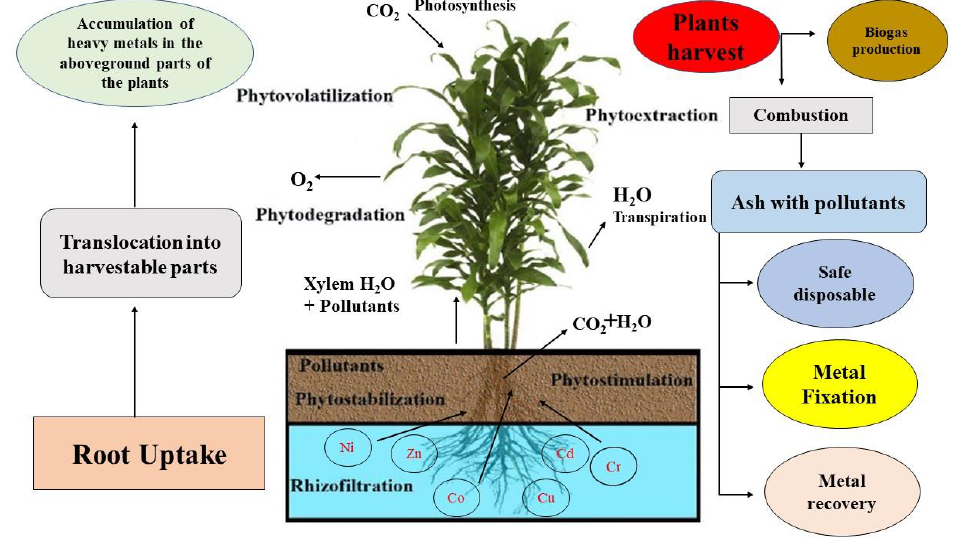
Figure 1. The mechanisms of different types of phytoremediation in plants with different management options of the end product.